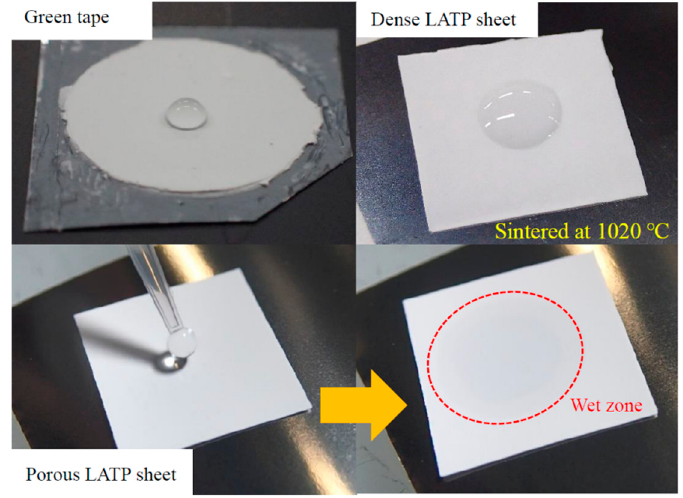
Figure 1. Images of the fabricated LATP electrolyte sheets.